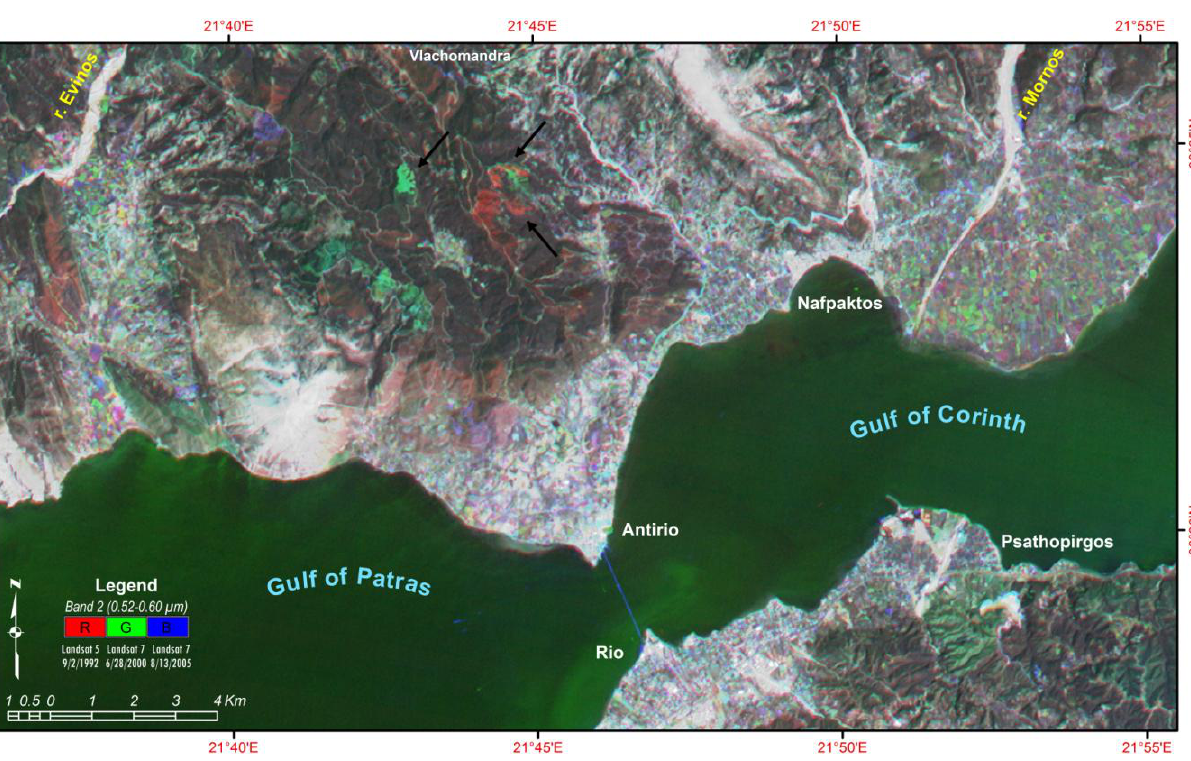
Figure 3. Multi-temporal pseudo-color image produced from layer stacking of Landsat satellite data (Band 2, 0.52 to 0.60 μm) with three different acquisition dates. Land surface destruction due to mass landsliding along roads and river banks, as well as other changes in bare soil and vegetation, can be identified. The black arrows point to alterations of the surface described in the